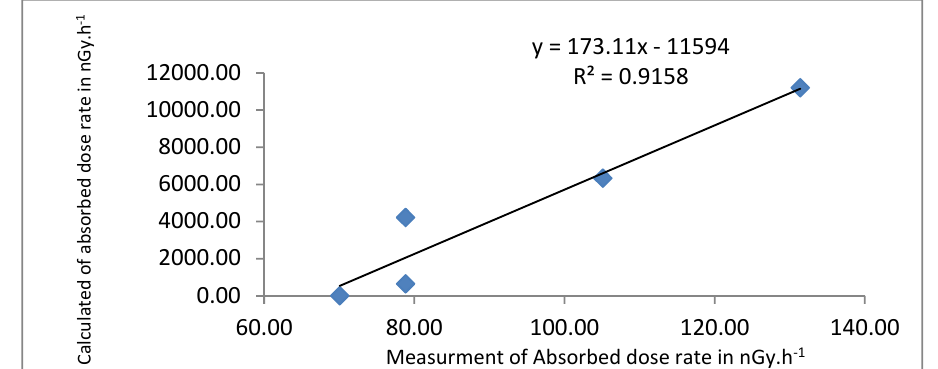
Fig 4: The correlation between measured and calculated absorbed gamma dose rate in the